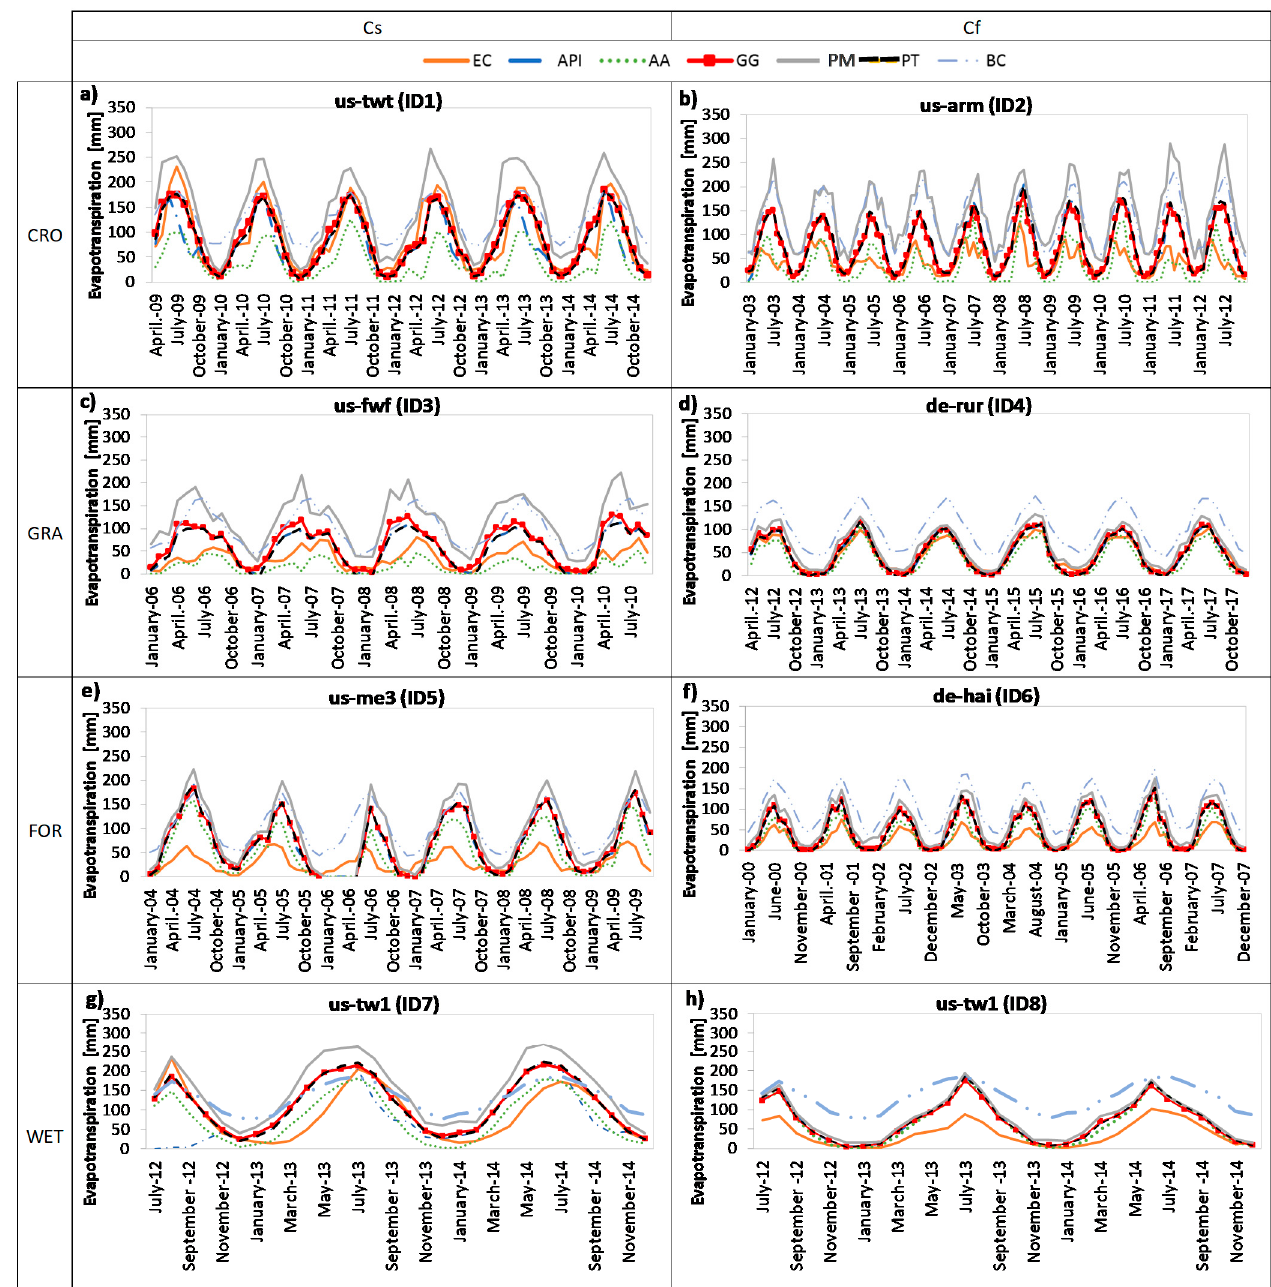
Figure 3. Temporal patterns of ET modelled using Antecedent Precipitation Index (API), Advection-Aridity (AA), Granger and Gray (GG), Penman-Monteith (PM), Priestley-Taylor (PT), Blaney–Criddle (BC) approaches and comparison with the measured fluxes for each of the selected site: ( a ) us-twt, ( b ) us-arm, ( c ) us-fwf, ( d ) de-rur, ( e ) us-me3, ( f ) de-hai, ( g ) us-tw1, ( h ) de-sfn.